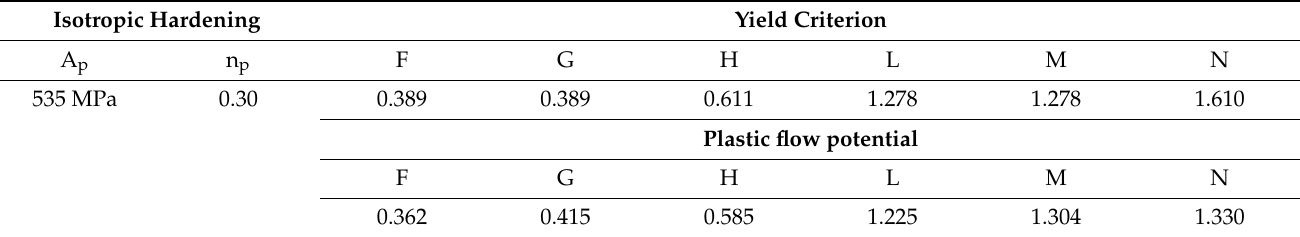
Table 2. Parameters of the Hollomon isotropic hardening function and non-associated Hill-48 model of the EK4 drawing steel. Isotropic